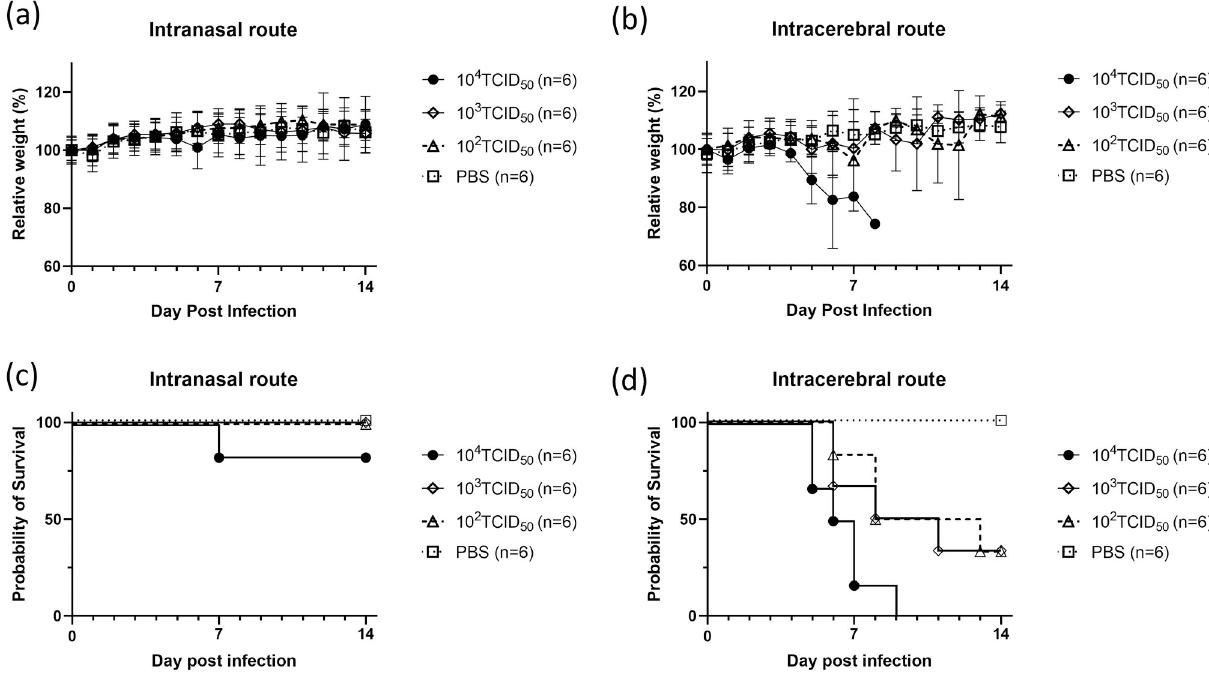
Fig 2. Survival curves and body weight dynamics of C57BL/6J mice infected intracerebrally and intranasally with different JCV titers. Percent body-weight change (a, b) and survival (c, d) of C57BL/6J mice intracerebrally and intranasally inoculated with JCV are shown. Six female mice in each group were inoculated with different doses of JCV and PBS as a control. Survival was determined using Kaplan-Meier analysis. Relative weight was calculated and is shown as mean values with standard deviations. Data were obtained from a single experiment.